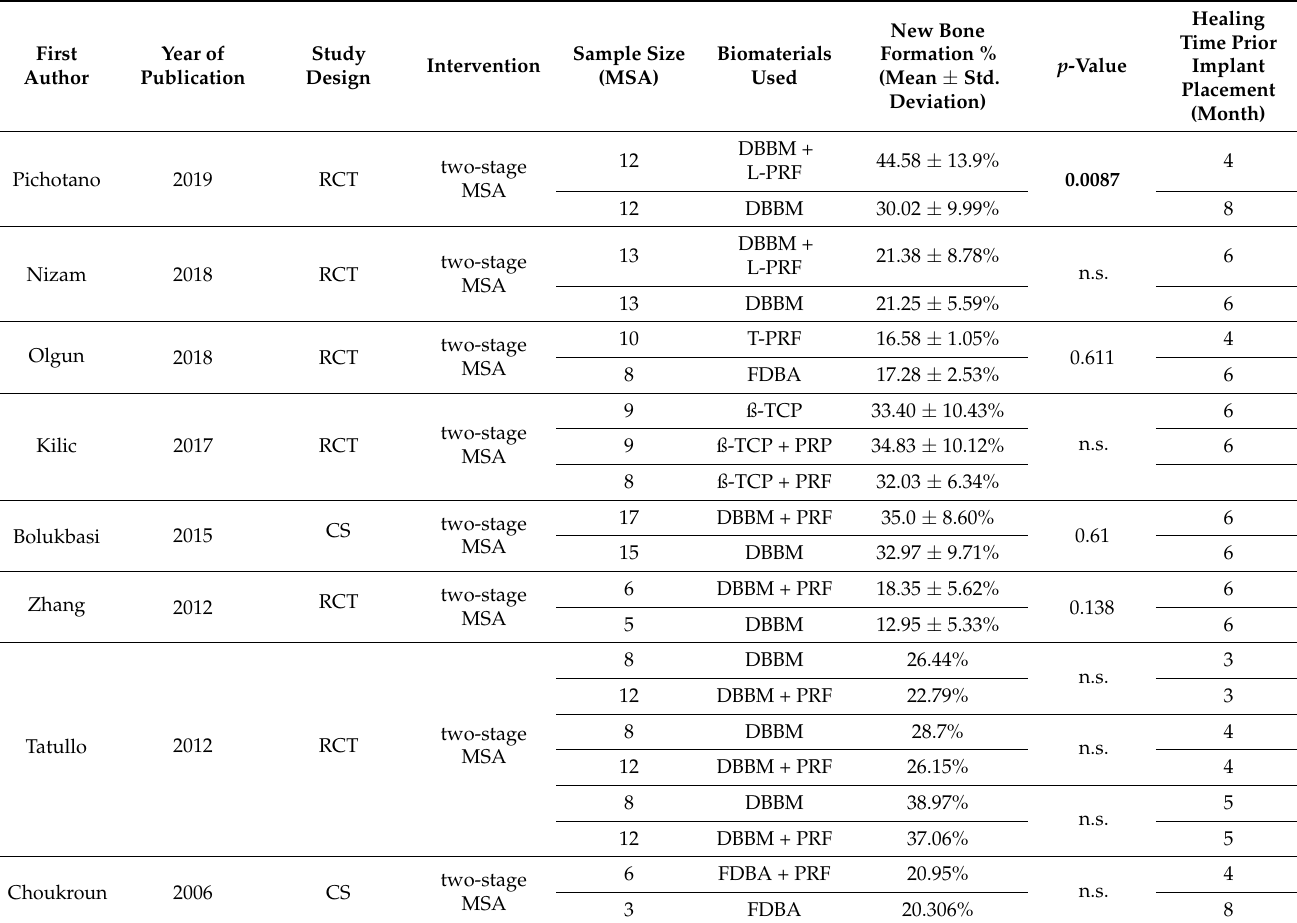
Table A2. Studies assessing the histomorphometric results of platelet-rich fibrin used for two-stage maxillary sinus augmentation. Statistical significance ( p < 0.05) is highlighted in bold. Abbreviations: maxillary sinus augmentation (MSA), randomized clinical trial (RCT), case series (CS), deproteinized bovine bone material (DBBM), leukocyte- and platelet-rich fibrin (L-PRF), titanium-prepared, platelet-rich fibrin (T-PRF), beta-tricalcium phosphate (ß-TCP), platelet-rich plasma (PRP), freeze-dried bone allograft (FDBA), not statistically significant